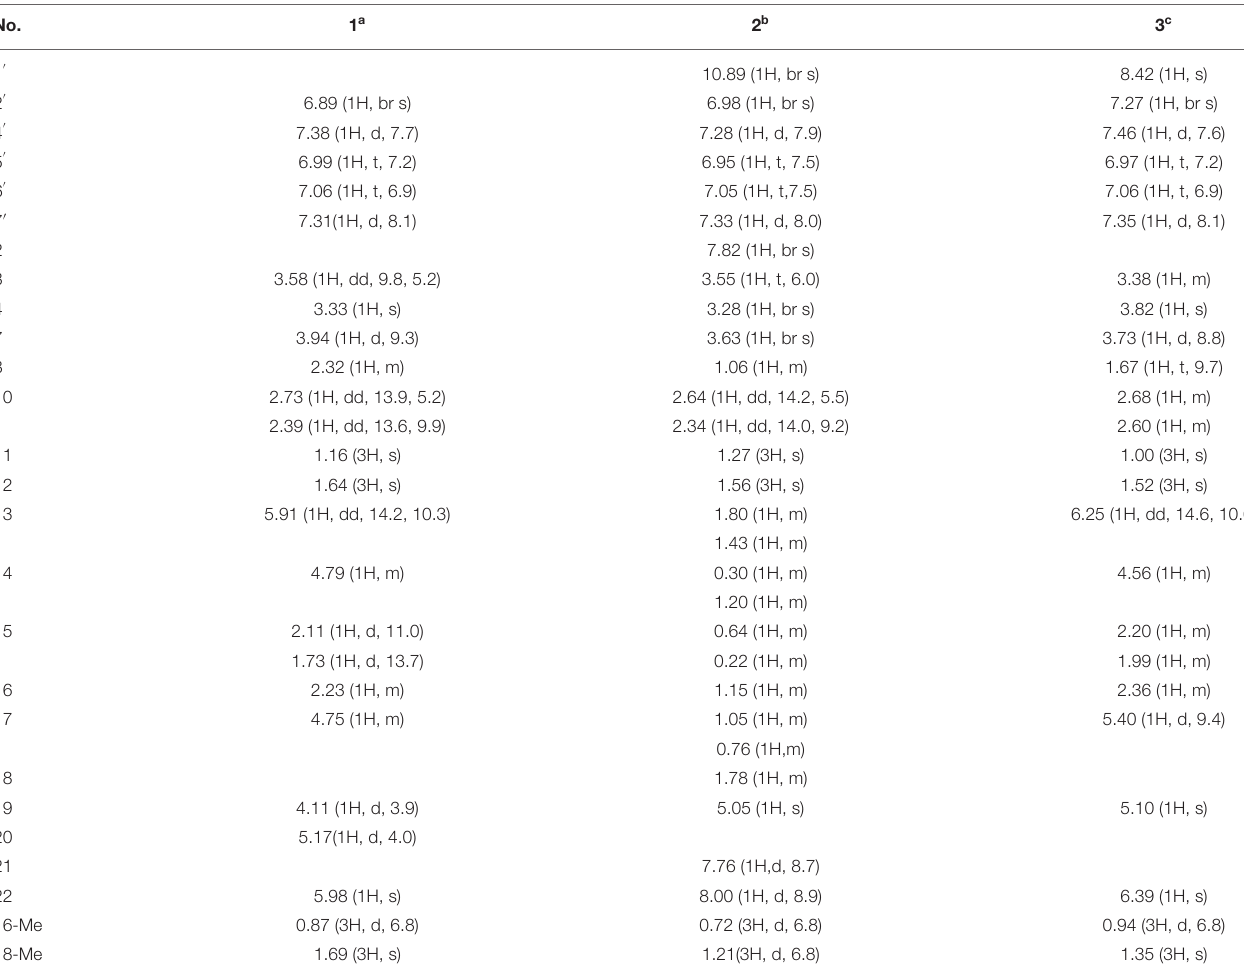
TABLE 1 | 1 H NMR spectroscopic data ( δ in ppm, J in Hz) for compounds 1 – 3 . No. 1 a 2